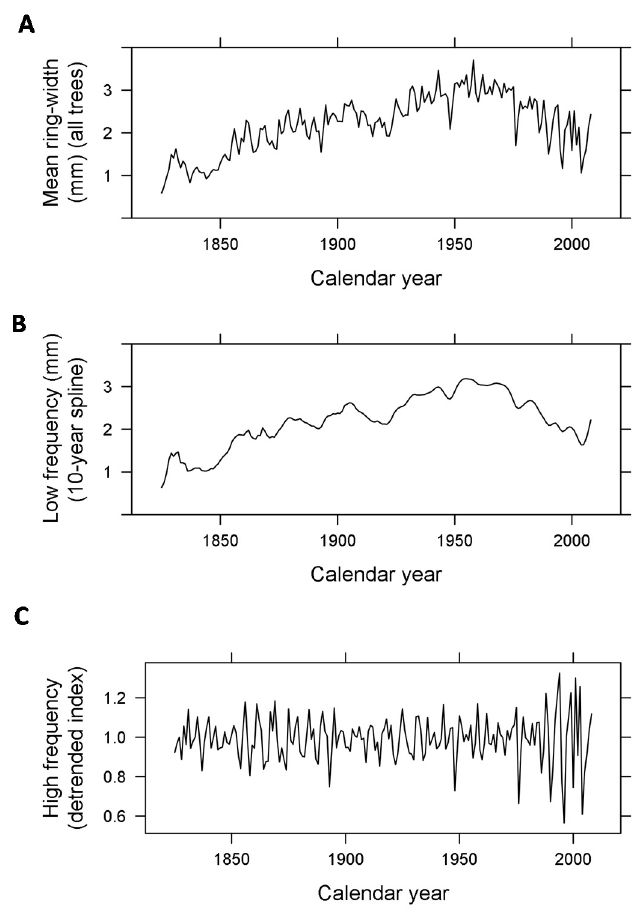
Figure 3. From ( A ) to ( C ), mean ring-width, low-frequency signal and high-frequency signal of the 149 beech trees. The radial growth of each of the beech trees was similarly divided into a low- and a high-frequency signal.